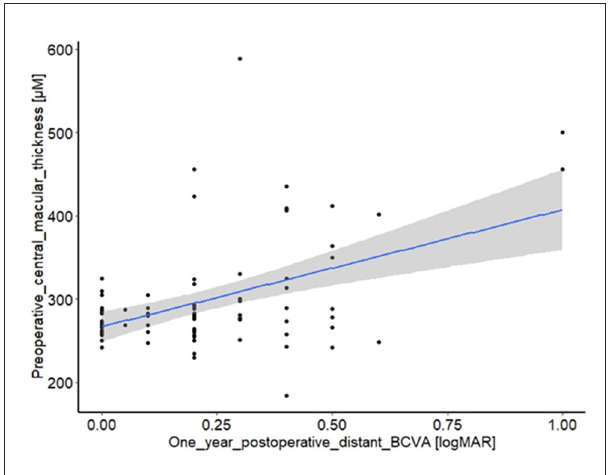
FIGURE2 The main effect of the univariate model. Correlation between preoperative central macular thickness ( µ m) and one-year postoperative distant BCVA (logMAR), p <